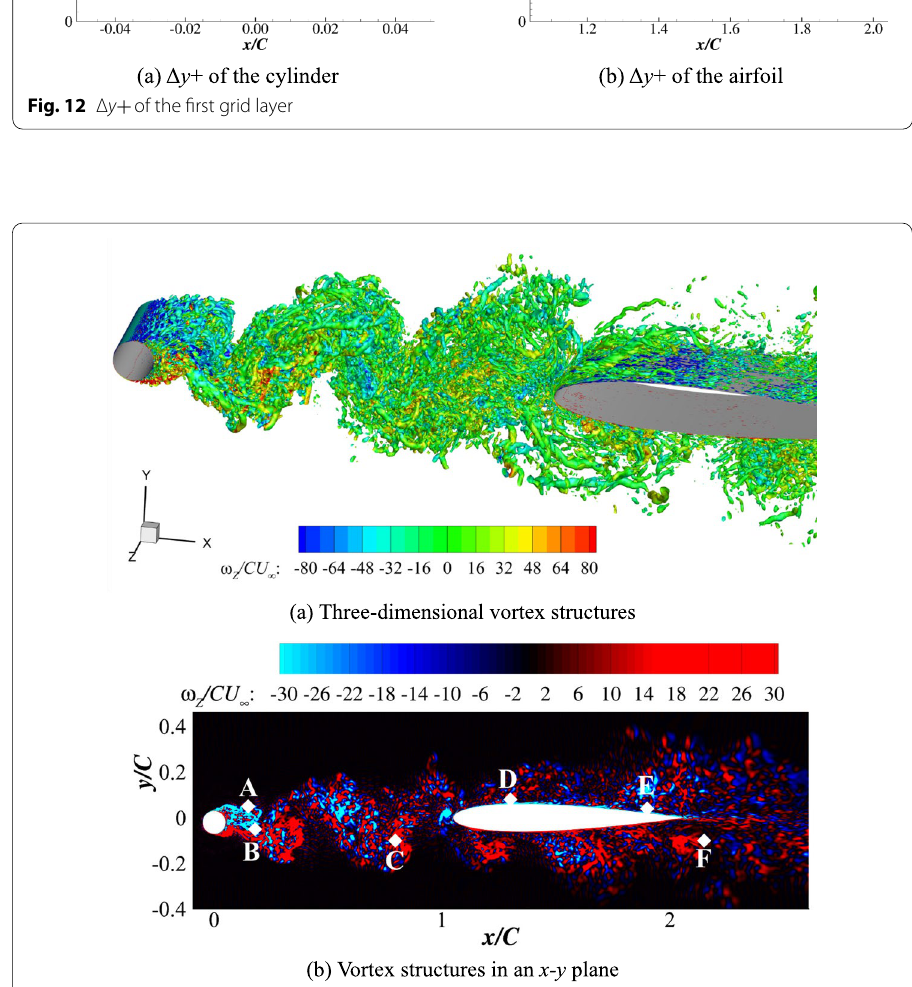
Fig. 13 Instantaneous flow fields of the rod-airfoil